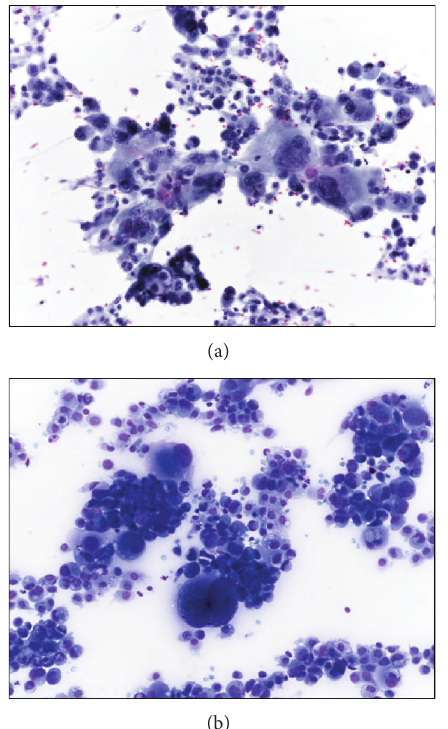
Figure 2: FNAB smears are usually made up of polymorphic neoplastic cells in a dirty necrotic background ((a) Papanicolaou stain, (b) May-Grunwald Giemsa